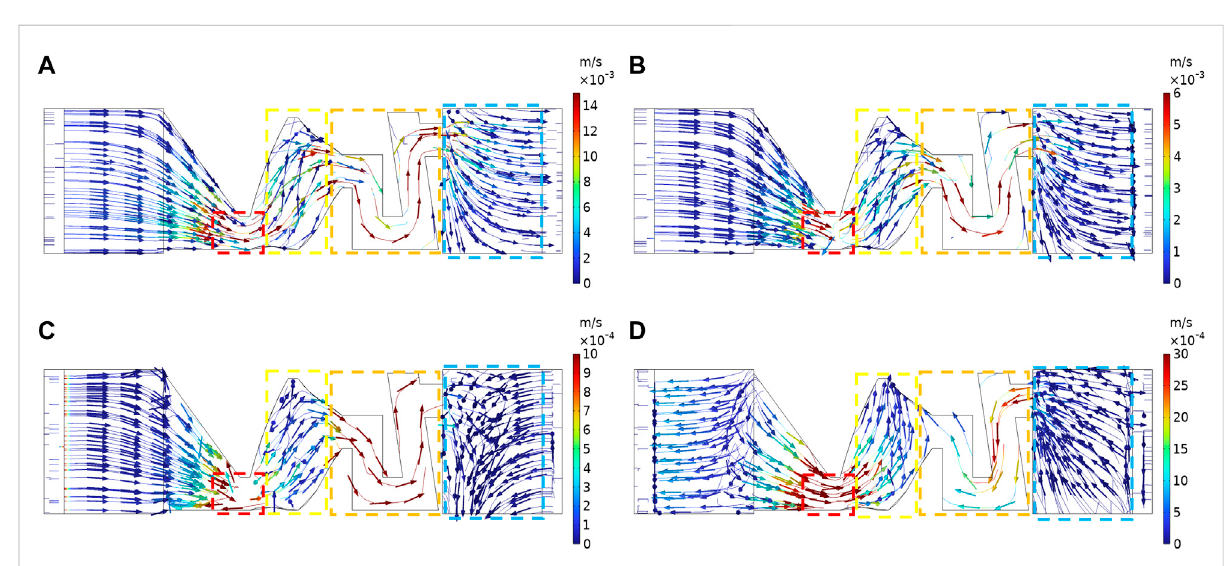
FIGURE 3 The velocity fi elds. (A) f = 40 Hz; (B) f = 200 Hz; (C) f = 1250 Hz; (D) f = 3150 Hz.